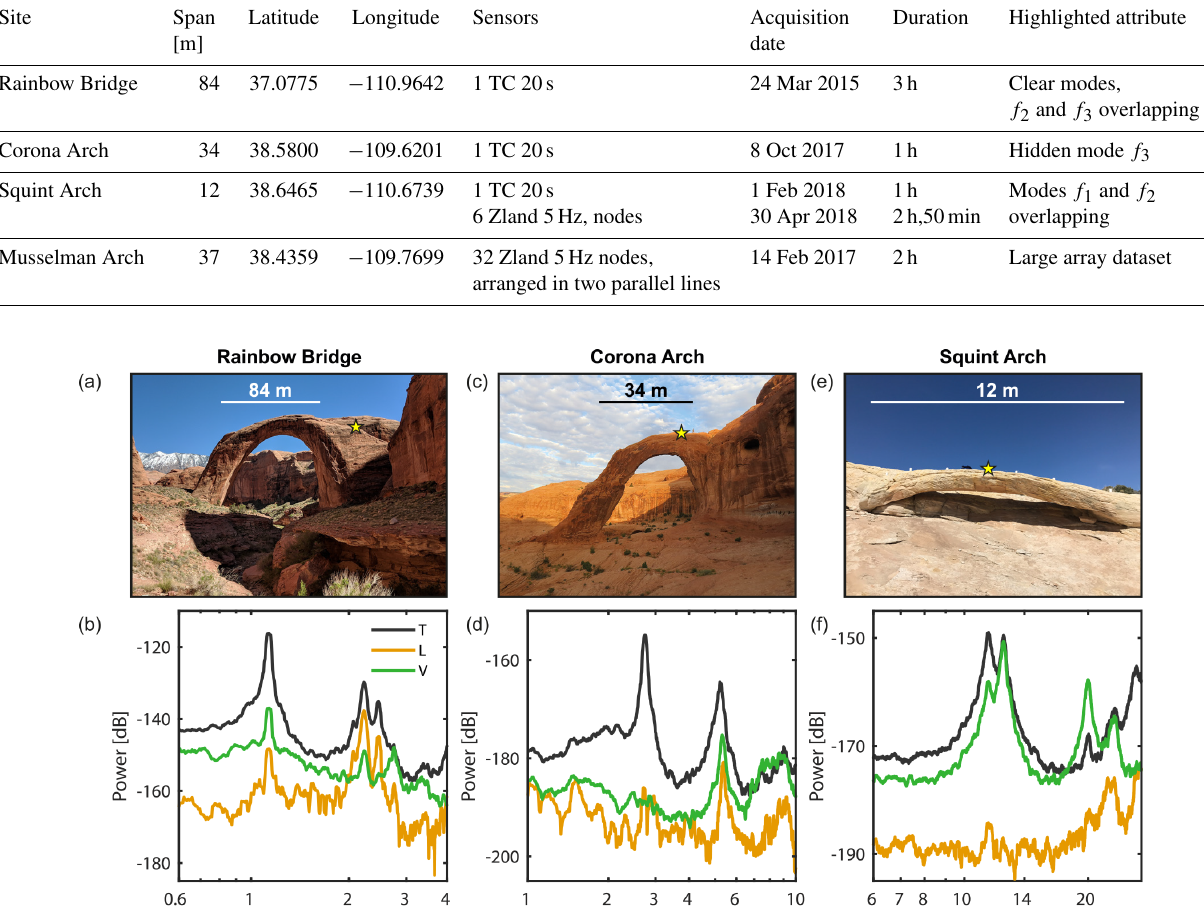
Table 1. Location, span, and data acquisition characteristics for each arch investigated (coordinates in WGS84).